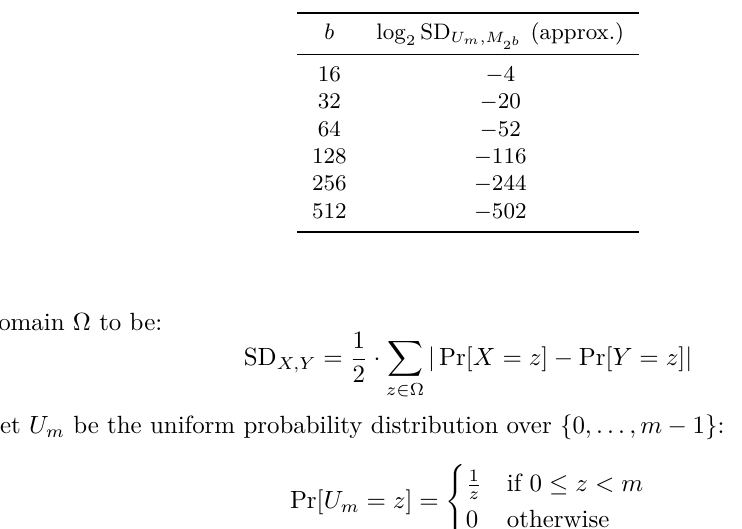
Table 5: Statistical distance between the uniform distribution over { 0 , . . . , m − 1 } and the distribution of random integers from 0 to 2 b − 1 reduced modulo m for hqc-128 ( n = 17 ,